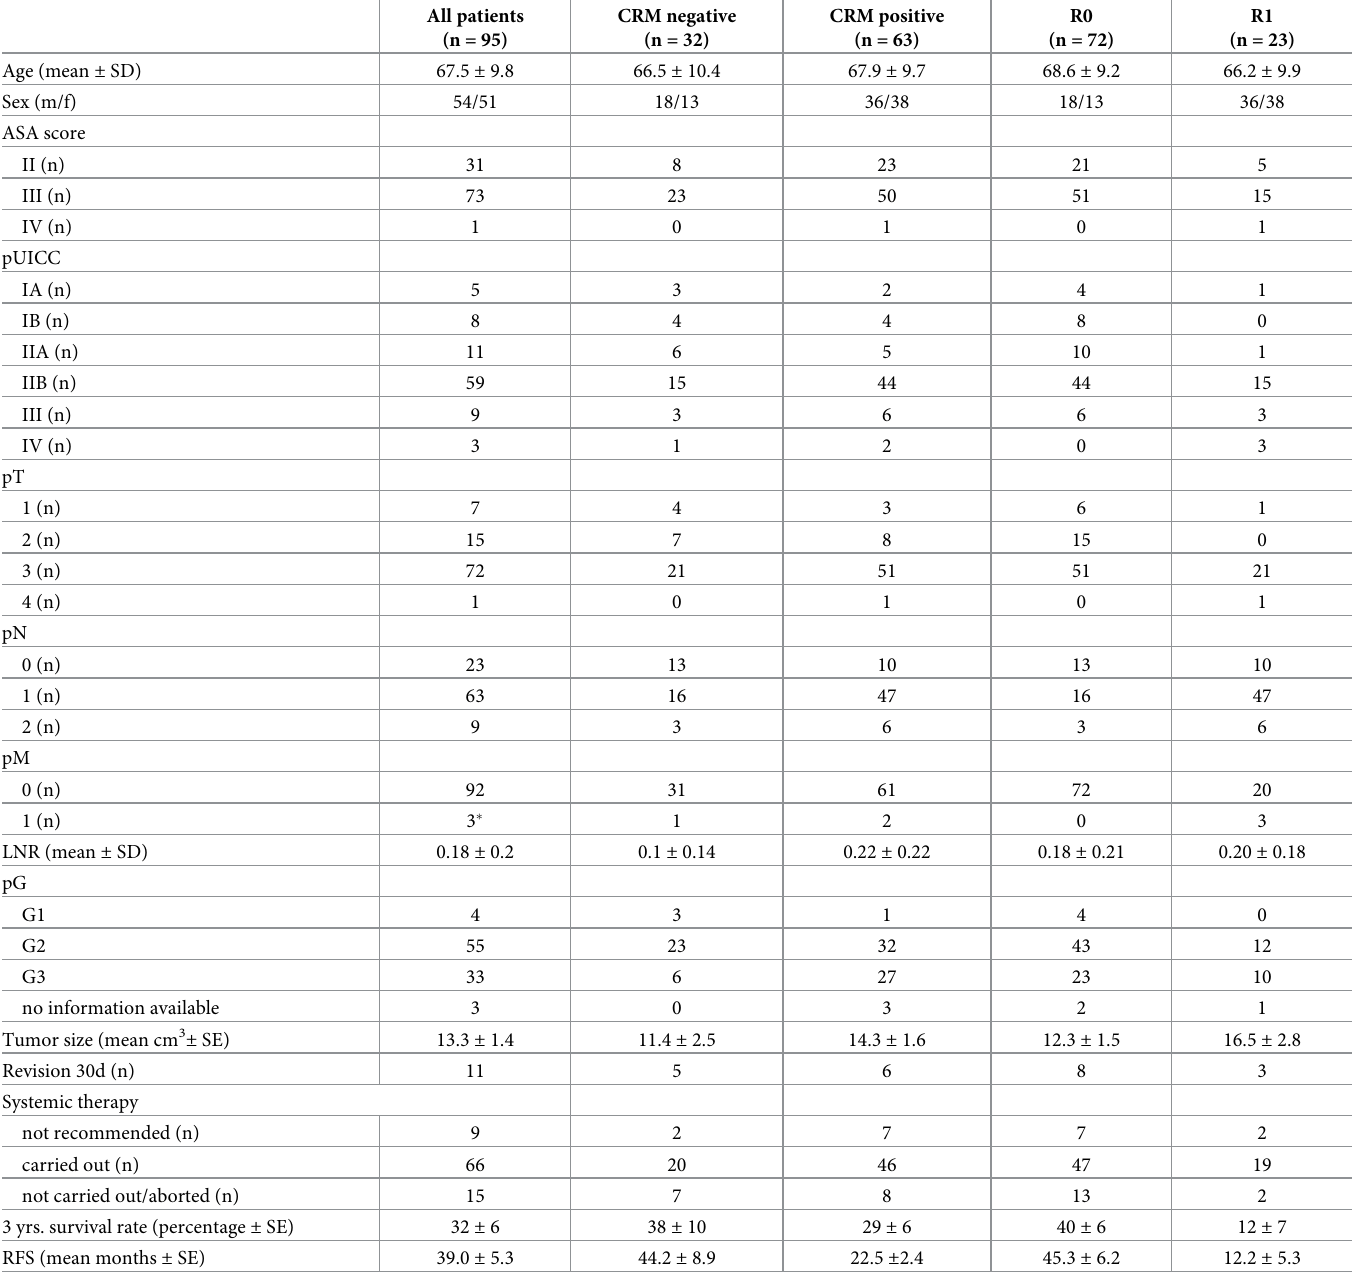
Table 1. Patient characteristics for all patients stratified by CRM status and R status